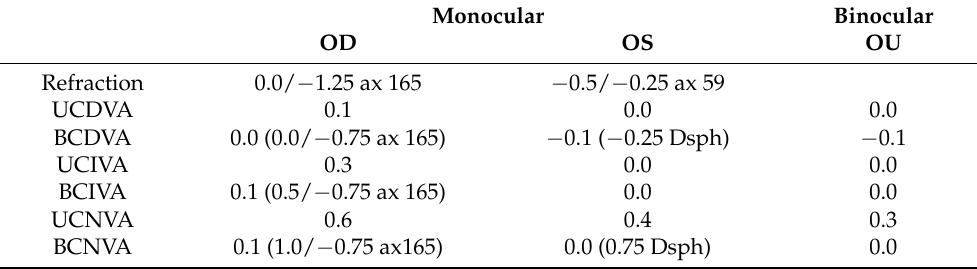
Table 2. Refraction and visual acuity (logMAR) 6 month after cataract